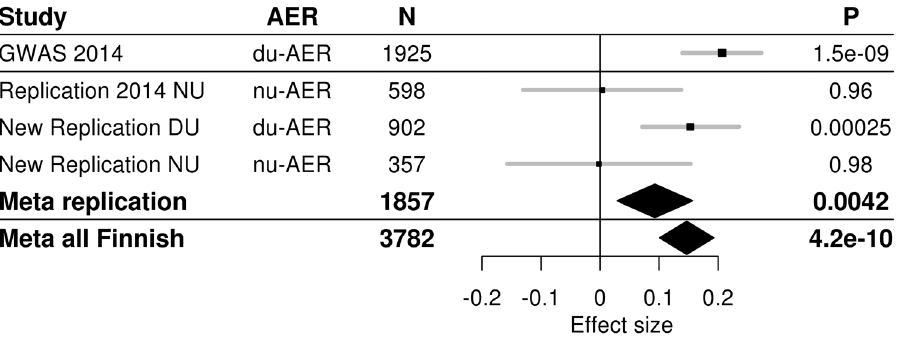
Figure 1. Forest plot of association between rs10011025 and AER in the original discovery cohort (GWAS 2014), in the previously reported Finnish replication set (“Replication 2014 NU”), and in the two novel Finnish replication sets (“New replication DU”, and “New replication NU”). DU: 24-hour urine. Meta replication: meta- analysis of all three replication cohorts; Meta all Finnish: meta-analysis of original discovery study and the three Finnish replication